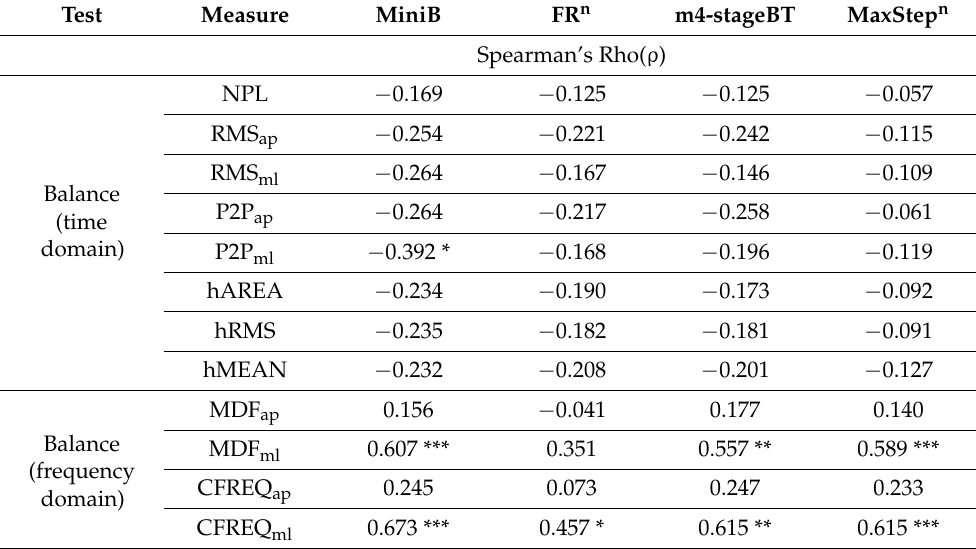
Table 5. Correlation results between clinical balance instruments and sensor-tests for position Feet Together (n = 31), using Spearman’s rho ( ρ ). Test